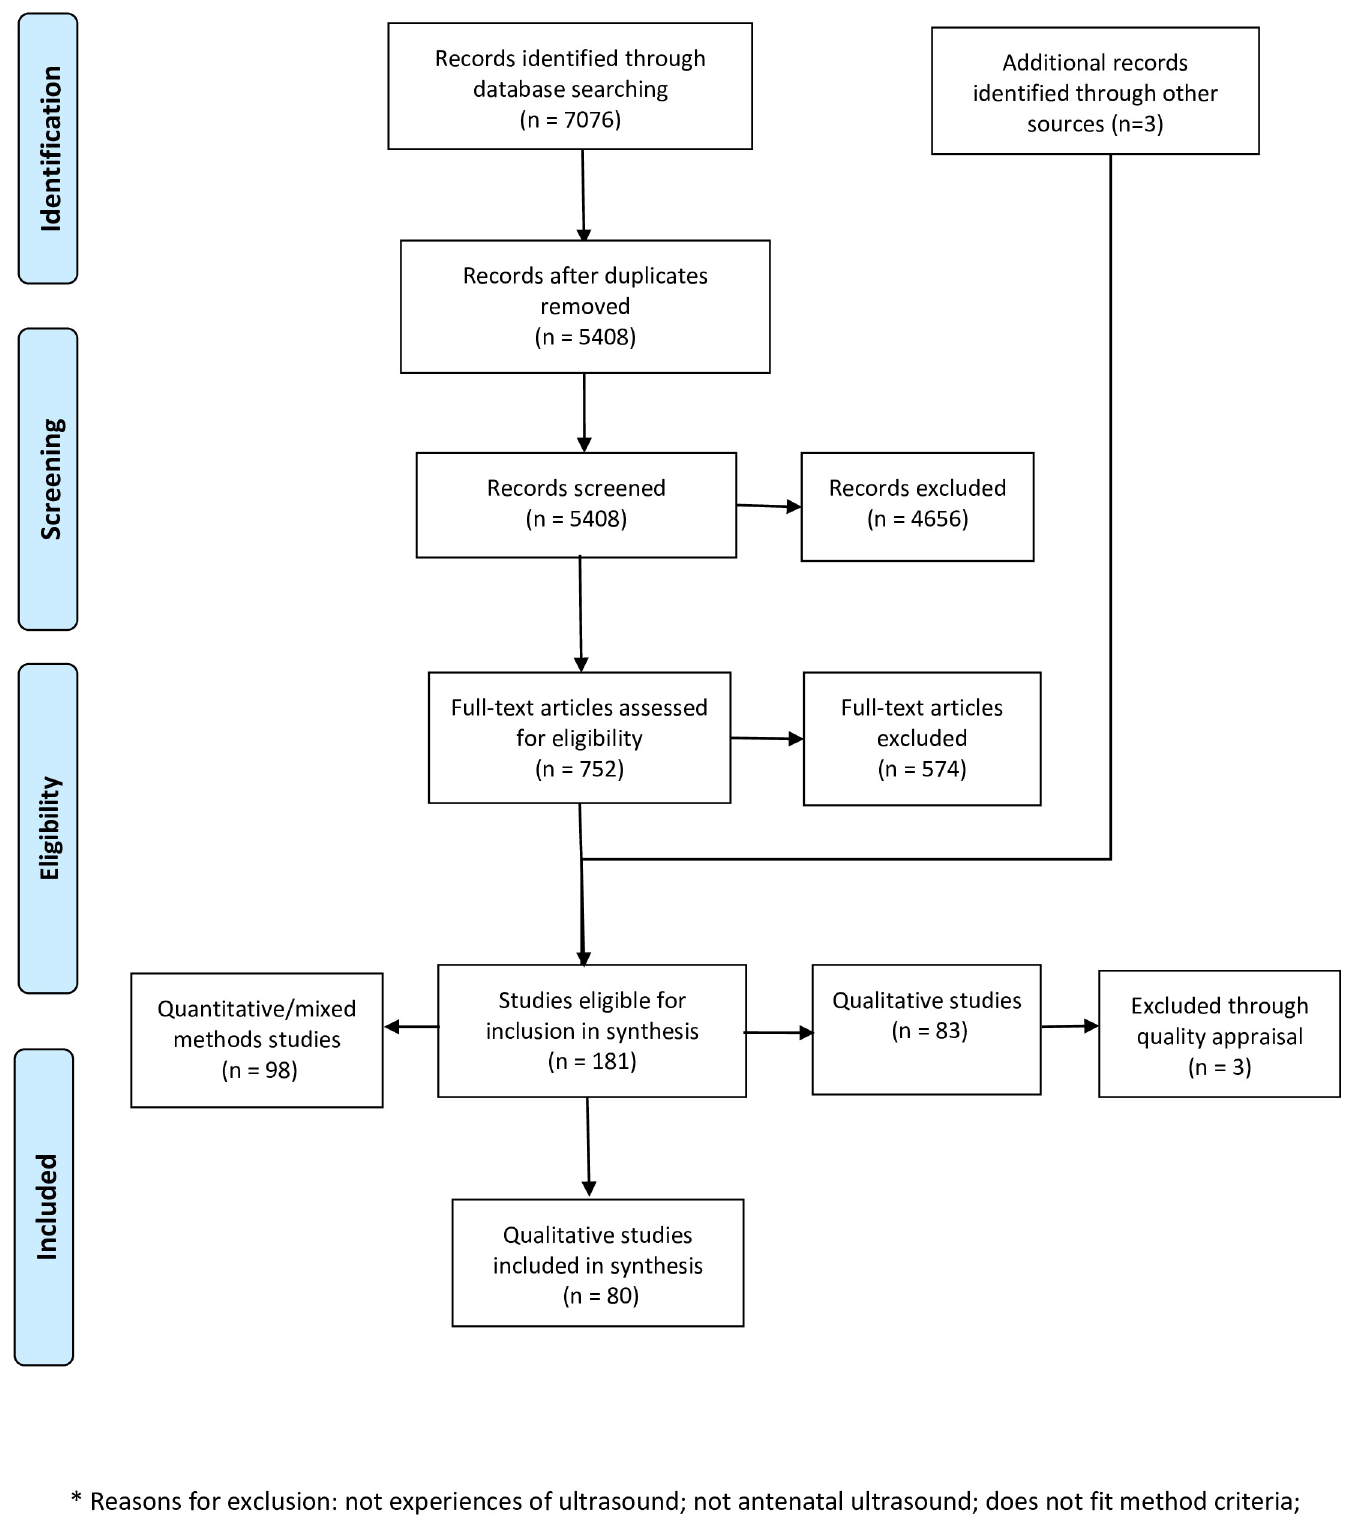
Fig 1. Screening and selection process.